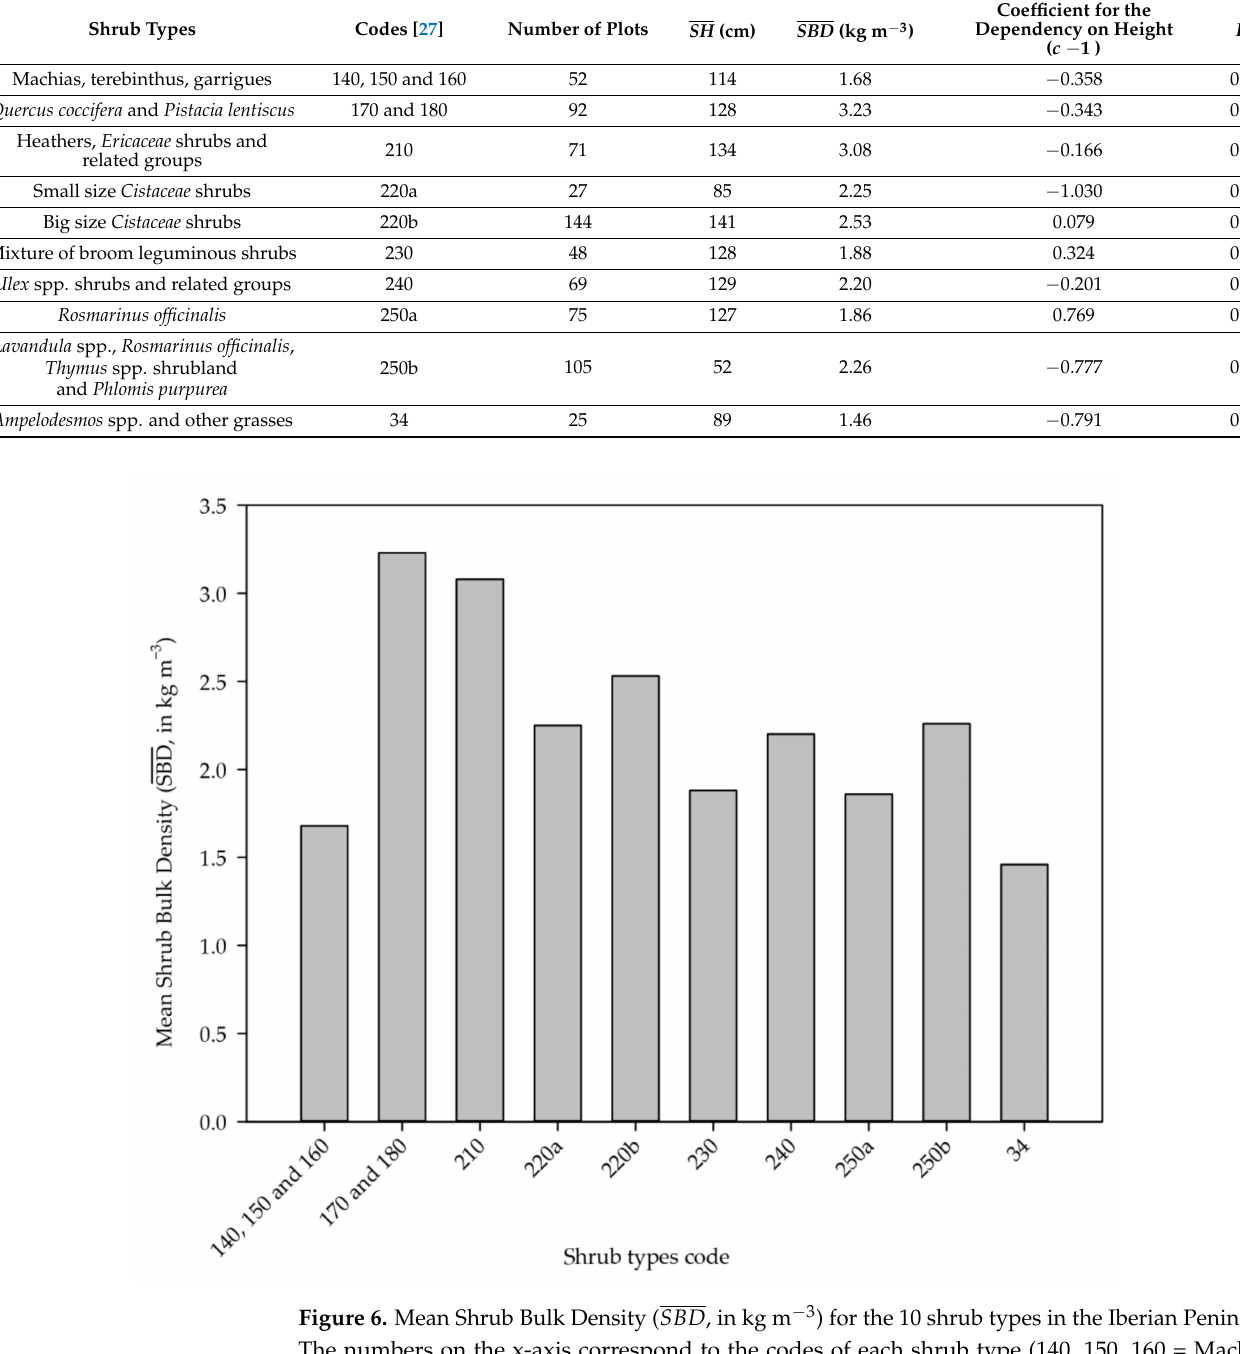
Table 1. Parameters of Equation (6) to estimate Shrub Bulk Density ( SBD ) for each of the 10 shrub types defined by Pasalodos-Tato et al. [27] (the second column contains the codes for each of the 10 shrub types), including foliage and small branches, from mean Shrub Height ( SH ) and mean Shrub Bulk Density ( SBD ).